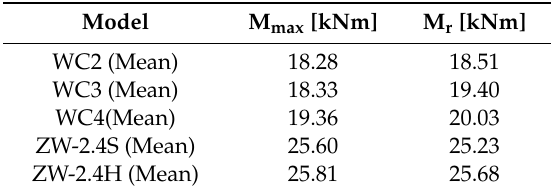
Table 3. Comparison of experimental and theoretical